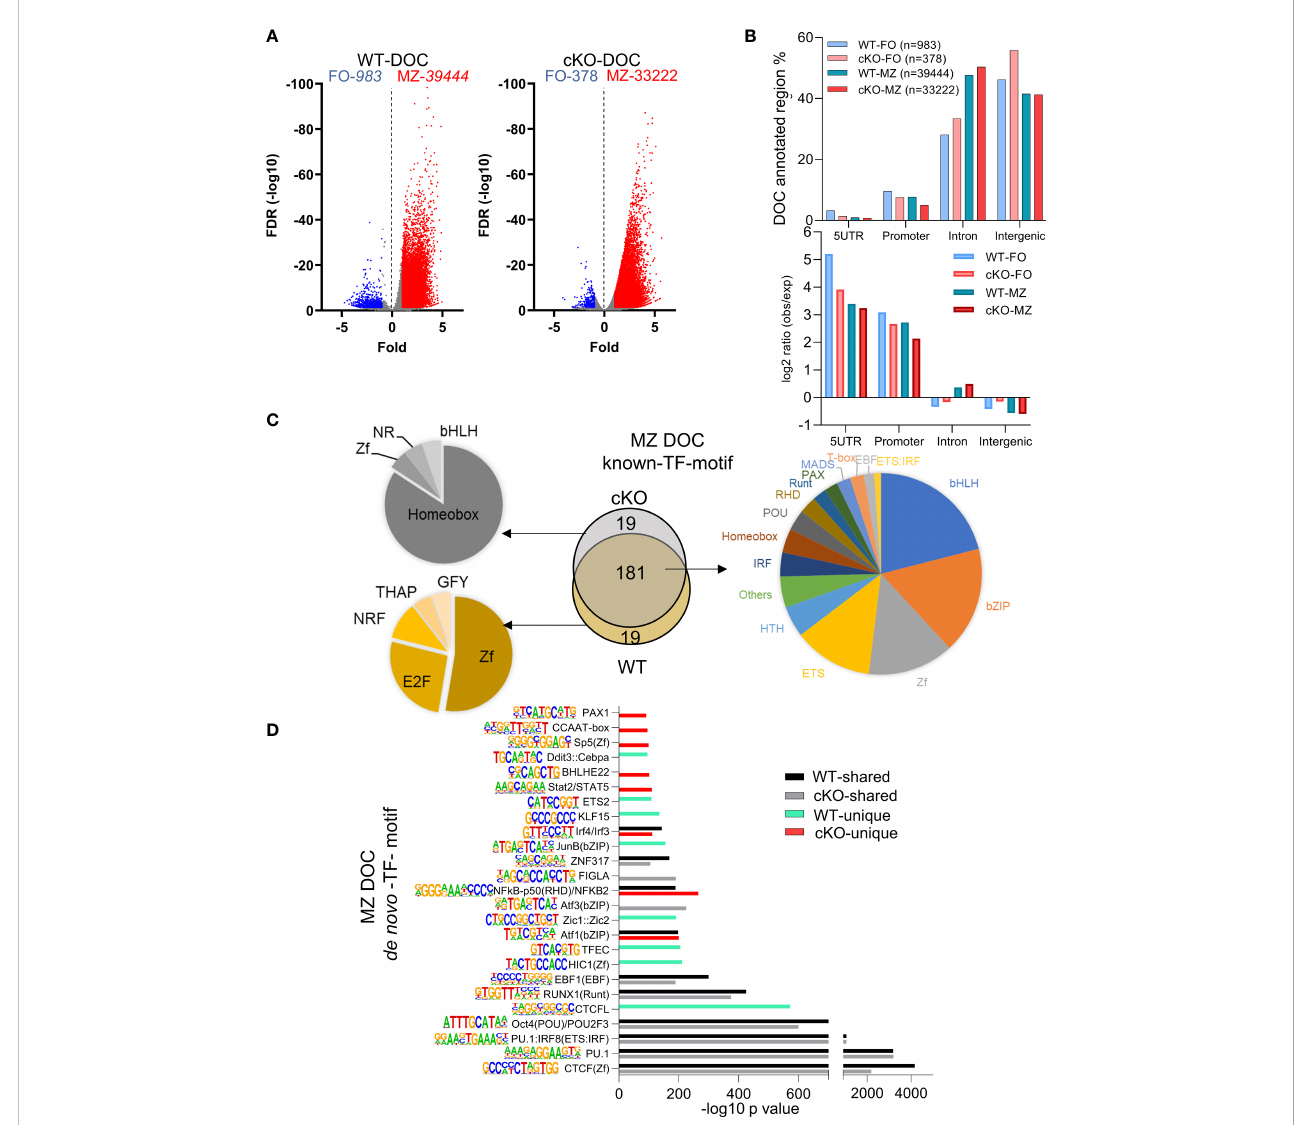
FIGURE 6 Transcription factors binding motifs in open chromatin of FO and MZ B cells. (A) Volcano plot showing the differentially open chromatin (DOC) from FO and MZ B cells of WT (left) and cKO (right); numbers of DOCs per cell type for the WT and cKO are shown on top. (B) The DOCs were annotated to the 4 genomic regions (5UTR, promoter, intron, intergenic) and the percentages of these DOC annotated regions are shown for the four cell types. Their observed vs expected values relative to genomic background is shown in bottom. (C, D) The top 200 transcription factor (TF) motifs of DOC of MZ from WT and cKO B cells identi fi ed by known (C) and de novo (D) TF motif algorithm of HOMER. (C) Venn diagram (middle) shows the number of predicted common and unique TF binding motifs. Common motifs are represented by the pie chart on the right while the unique ones are represented on the left side. (D) bars represent the -log10 p-value. cKO selective transcription factor motifs are marked by red color columns while WT selective transcription factor motifs are marked by light green color columns. Motif logos are listed next to each transcription